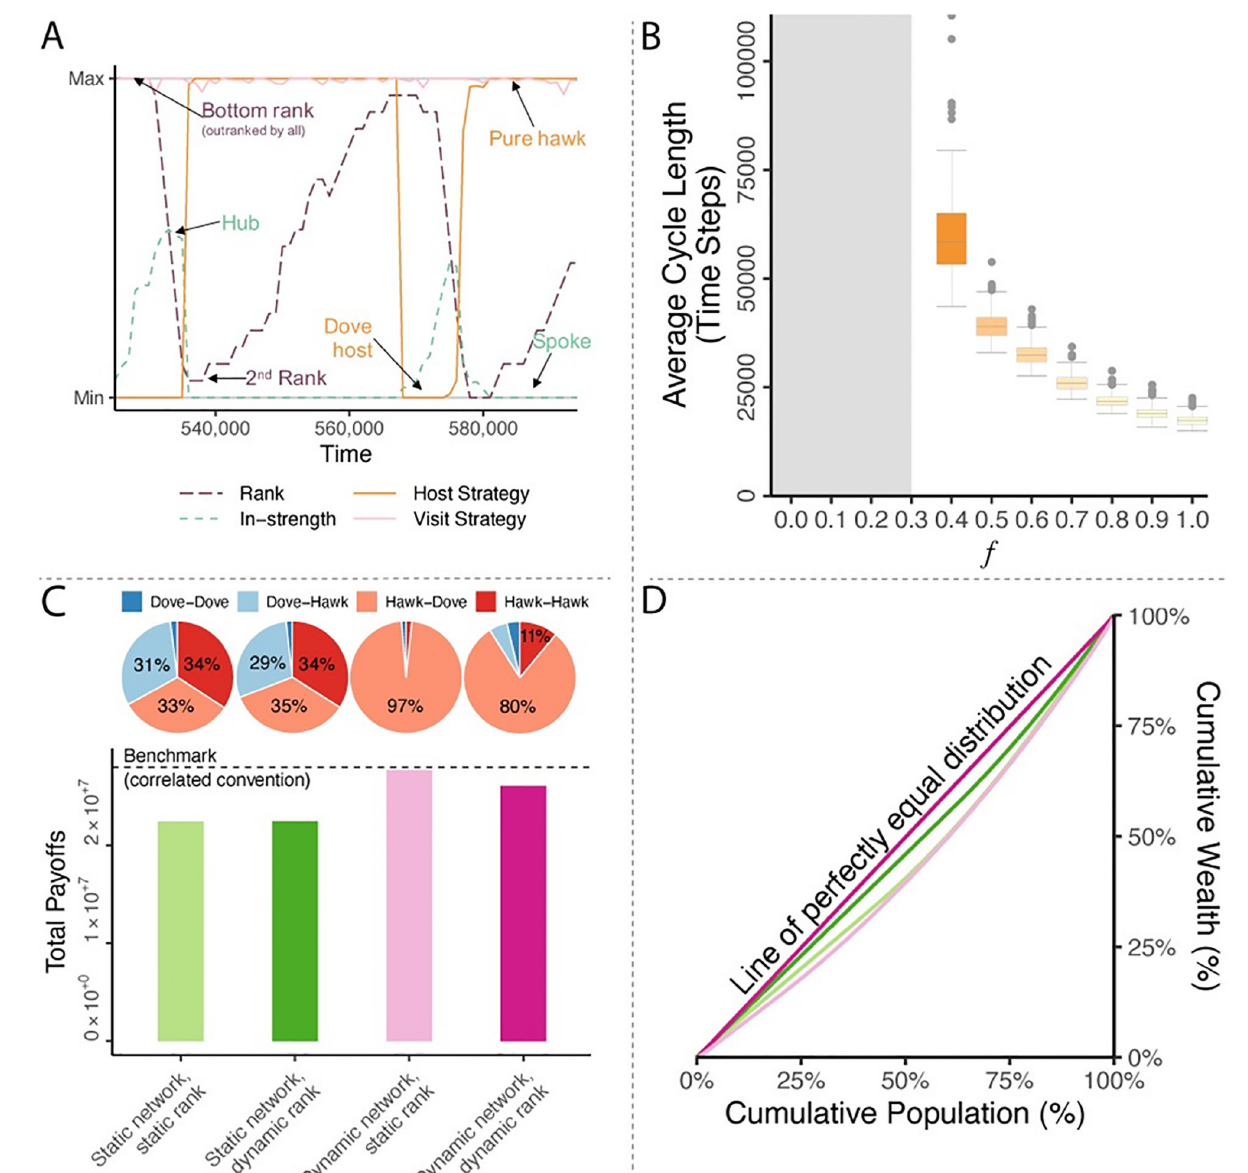
Fig 5. Cycles have equalizing force that reduce wealth inequality. A , Two example cycles of coupled changes in network positions, strategies, and ranks ( dh = 0.4; dd = 0.6; f = 0.4). B , Below the critical value f < dh , ranks remain static and no cycles emerge (the grey shaded area). At f � dh , a phase transition occurs and coupled cycles emerge. The cycle length varies as a function of f . Cycles are shorter when power asymmetry is higher. C , Static networks lead to low total payoff due to inefficient hawk-hawk conflict while partner choice stabilizes the convention and leads to high payoffs. D , Static networks lead to high inequality as bullies earn higher payoffs. Partner choice with static ranks reverses the pattern with low-ranking individuals earning high payoffs as they attract more visitors. Partner choice and dynamic ranks preserving perfect equality among individuals. ( dh = 0.4; dd = 0.6; f =